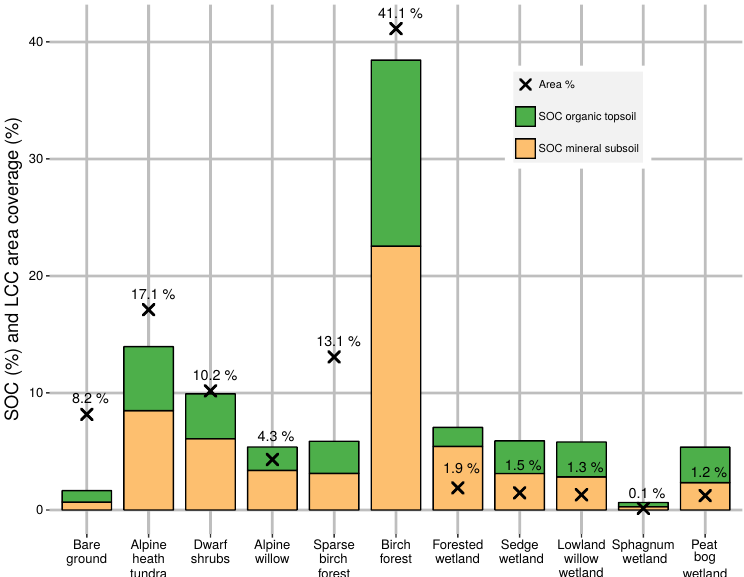
Figure 7. Partitioning of modeled total soil organic carbon (SOC) storage and respective land cover class coverage in % using a random forest predictor. The height of the column represents the fraction of the SOC–Tot. The mineral SOC is the amount of SOC–OL subtracted from the SOC–Tot. Crosses indicate the percentage areal coverage of the respective land cover class of the total landscape soil